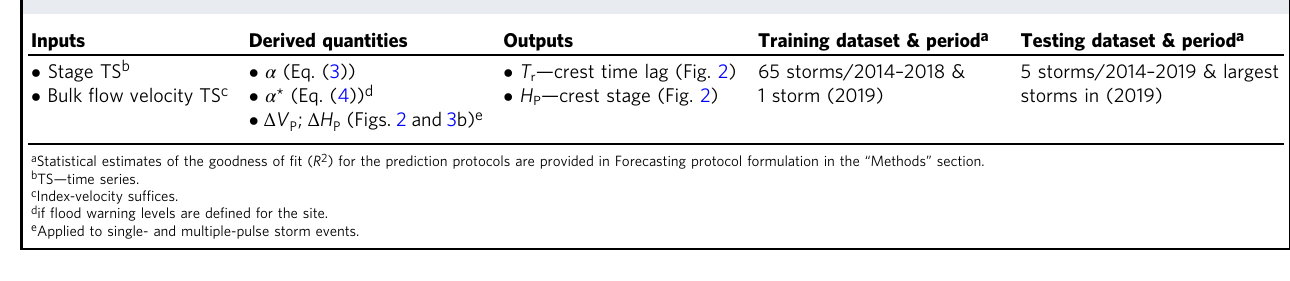
Table 3 Summary of essential data used for protocol testing and validation.